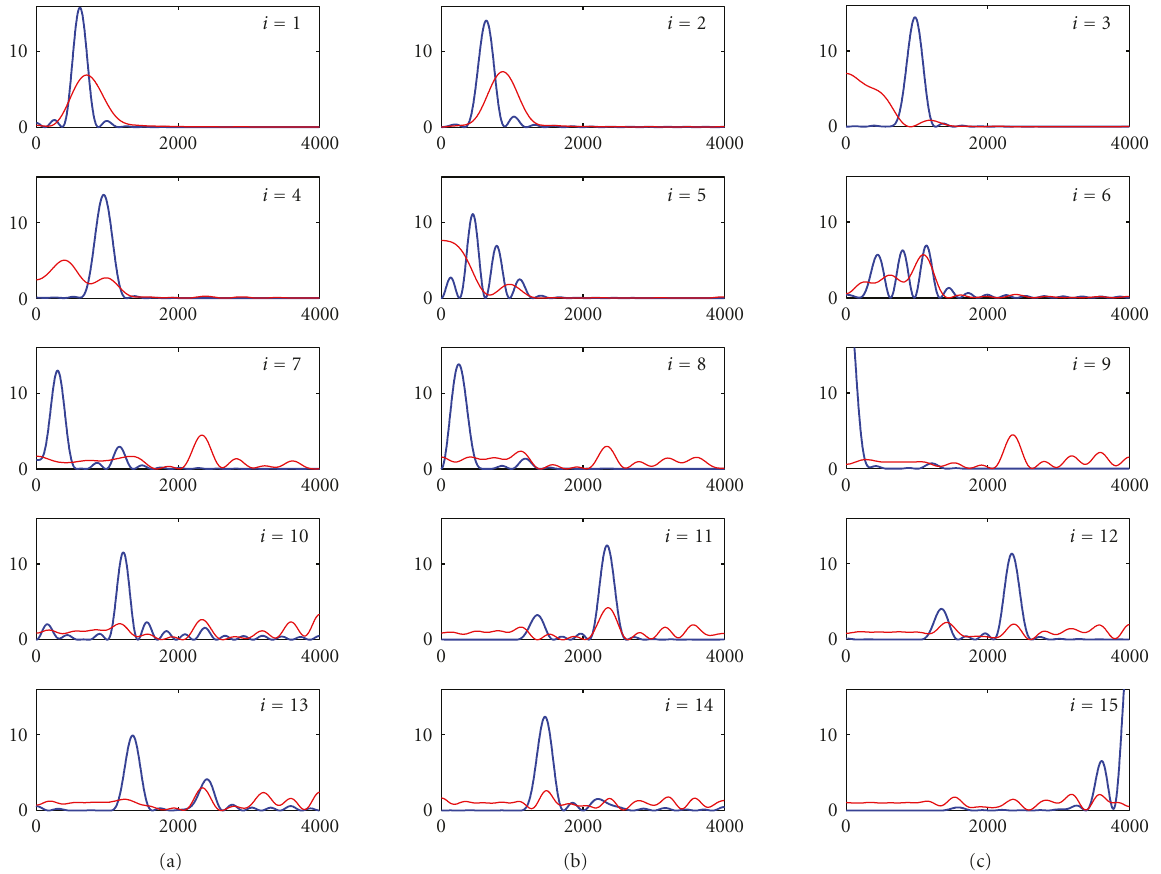
Figure 11: Frequency responses (Magnitude (dB) versus Frequency (Hz)) of the FIR filters for the truncated SVD algorithm and the high- rank ULV algorithm hulv (which produce LS estimates), applied to the test problem in Figure 5. Thick blue lines are SVD filters; thin red lines are ULV filters.